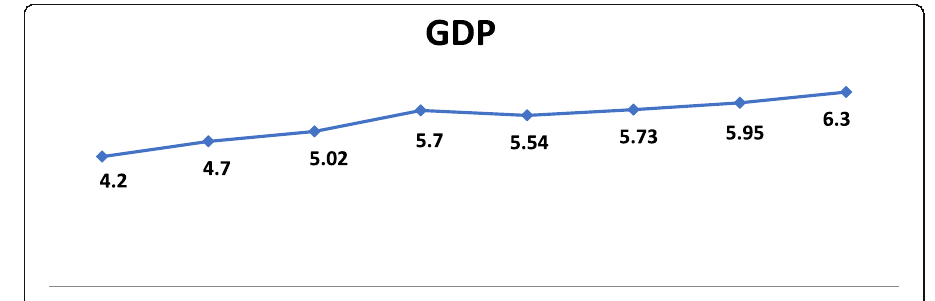
Fig. 1 GDP 2010 – 2017. Source: Data published by commercial banks and CBK processed by the